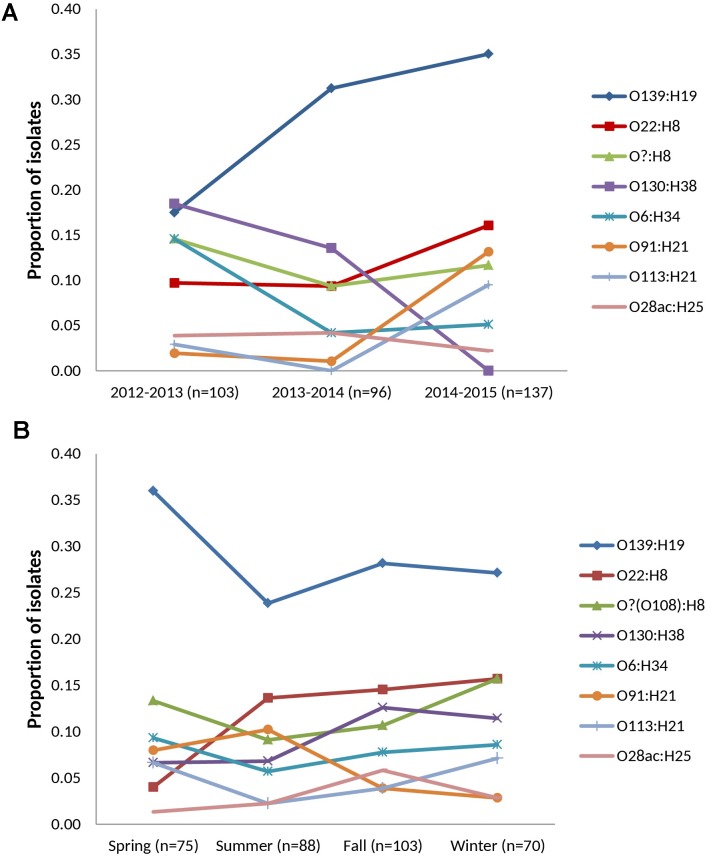
Temporal distribution of prevalent serotypes among heifer isolates. (n = 336 strains) (A) cohort-year. (B) seasonal. Prevalent serotypes (colored lines): serotypes isolated from >10 samples in the study.